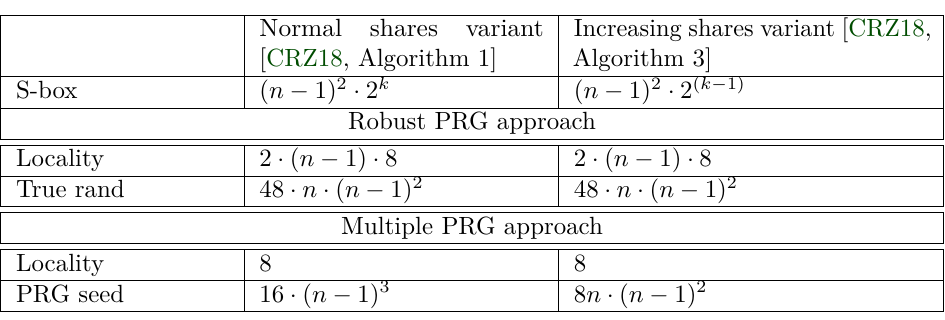
Table 4: Summary of locality, the total number of true and pseudorandom bits required for a full block cipher execution of AES-128 using the robust and the multiple PRGs approaches. The values represent number of